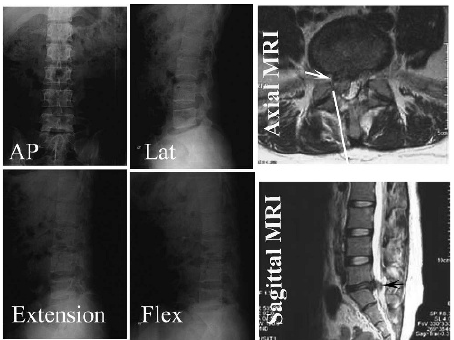
Figure 1 - Typical case: Female, 27 years old, relapsed one year after microendoscopic discectomy for L5S1 disc herniation. The lumbar disc herniated, along with repeated annulus fibrosus rupture in situ (see arrows). The X-ray showed fair stability of the lumbar spine, no significant decrease in the intervertebral space, and unobvious facet joint degeneration. Microendoscopic discectomy was applied along the original surgical approach (line shown), and the exposed herniated disc was removed from the interior facet joint.